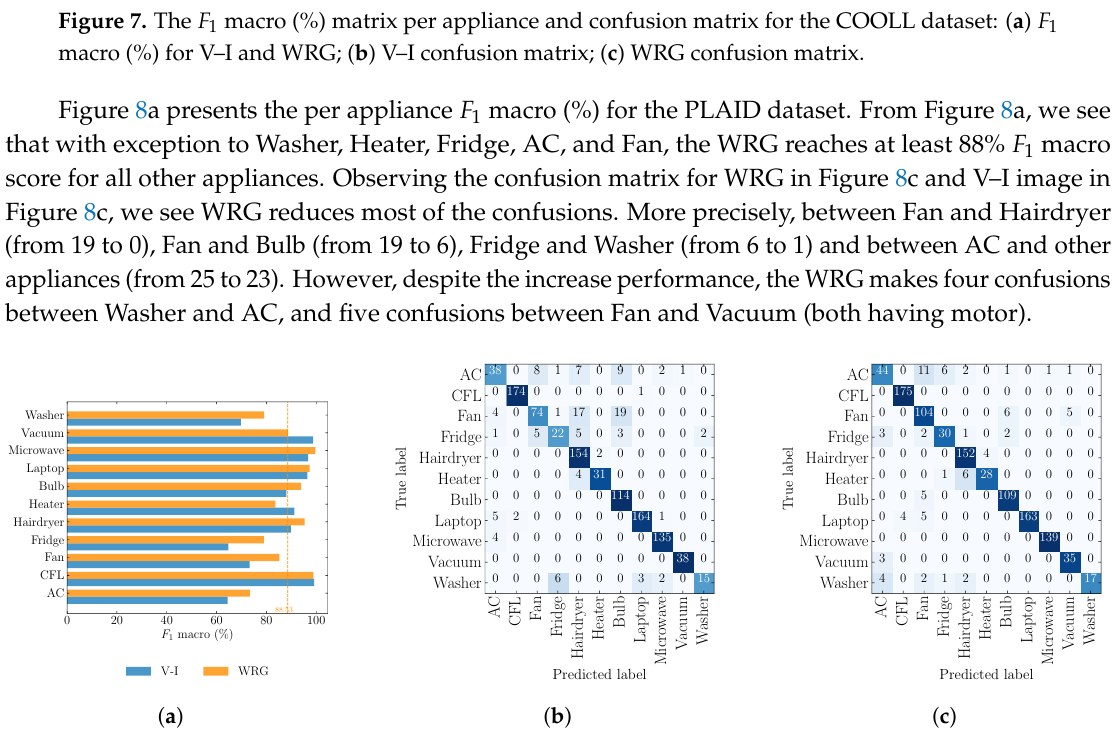
Figure 8. The F 1 macro (%) matrix per appliance and confusion matrix for the PLAID dataset: ( a ) F 1 macro (%) for VI and WRG; ( b ) V–I confusion matrix; ( c ) WRG confusion matrix; AC = air conditioning, CFL = compact fluorescent lamp, ILB = incandescent light